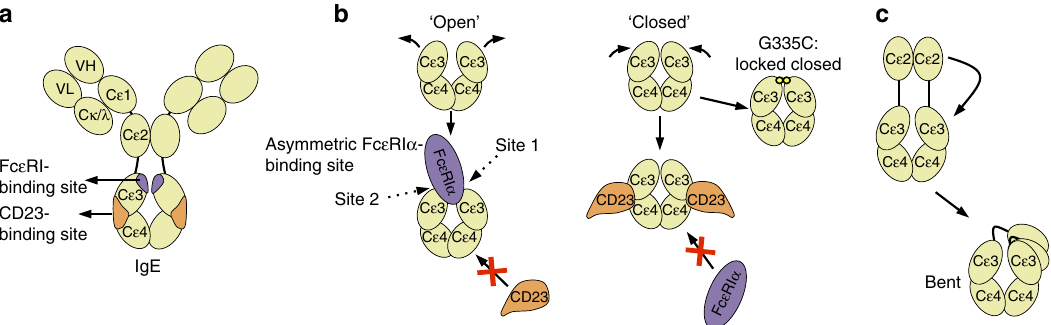
Figure 1 | Organization and conformational rearrangements of the IgE-Fc. ( a ) IgE and the relative locations of the Fc e RI a - (purple) and CD23 (orange)-binding sites. ( b ) A representation of open and closed conformations of the IgE-Fc 3–4 domains (including the IgE–G335C–Fc 3–4 mutant locked in a closed conformation), and a representation of the reciprocal allosteric inhibition by Fc e RI a (purple) and CD23 (orange). ( c ) A schematic of the bent conformation of IgE, and the relative position of the C e 2